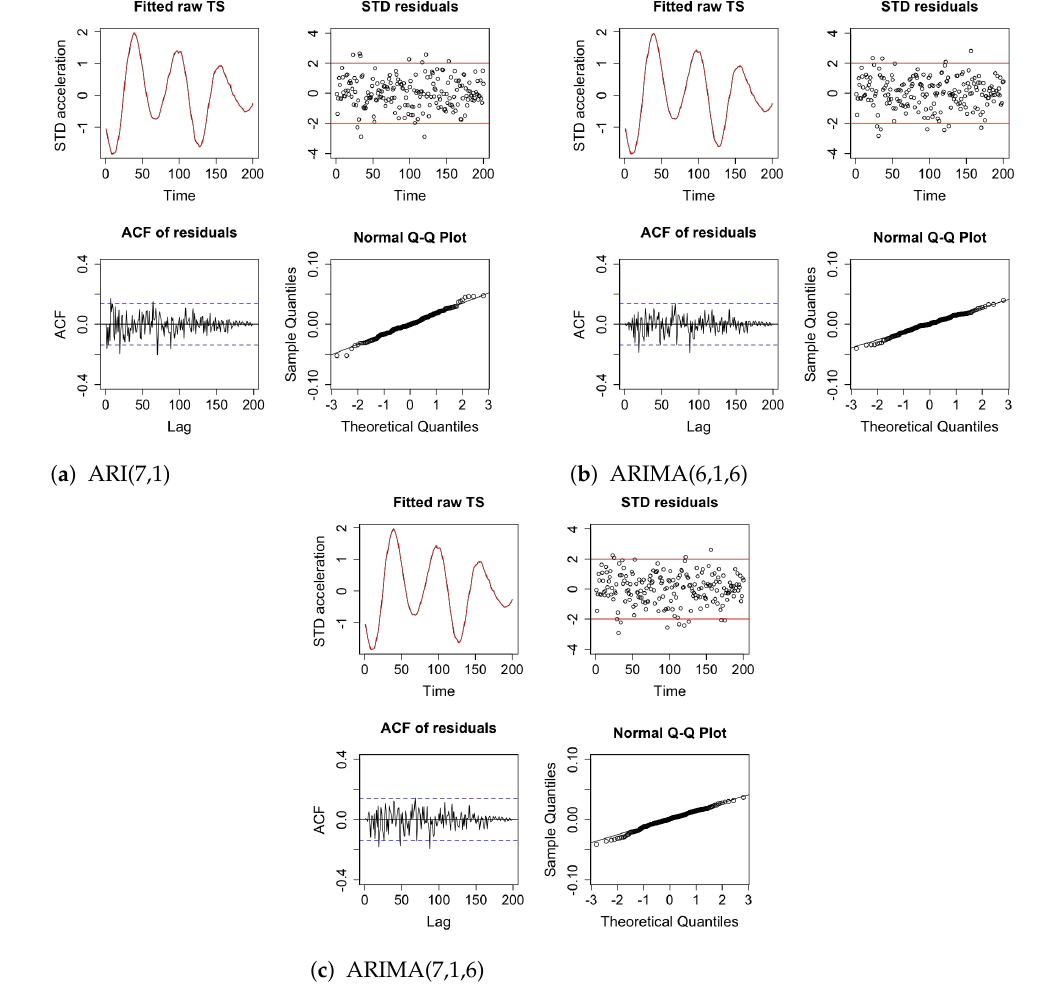
Figure 11. Residual diagnosis for the three candidate